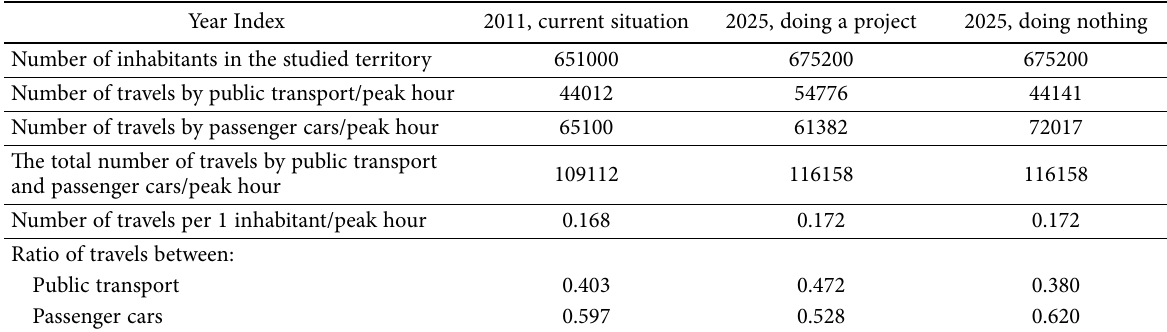
Table 1. Mobility indices of inhabitants